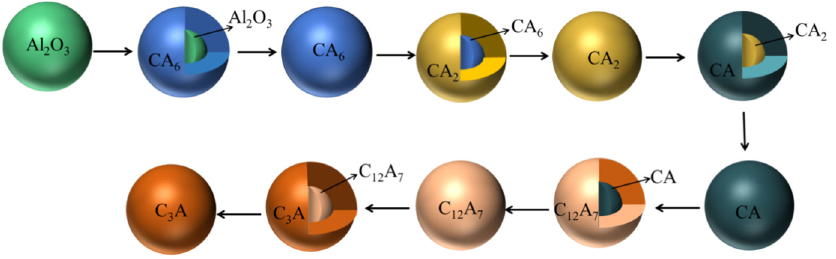
Figure 6. Kinetic model of alumina inclusions in calcium-modified steel. Taking the transformation of CA inclusions into C 12 A 7 as an example, the process is divided into the following three steps.